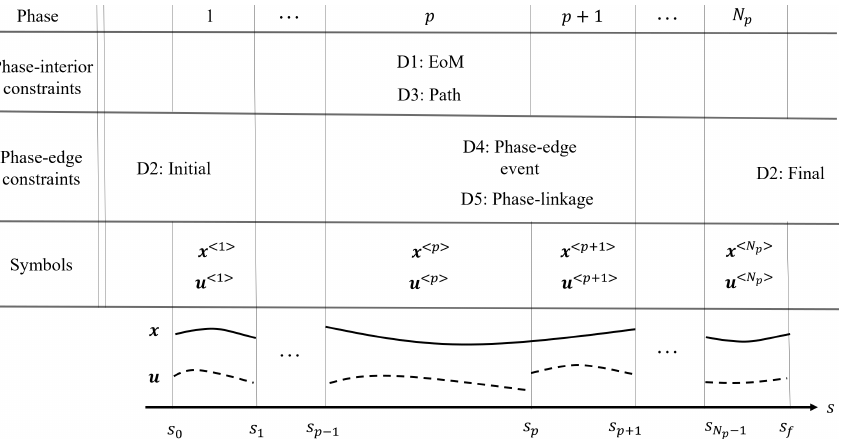
Figure 3. Overview of the constraints and symbols specific to phases. The constraints are categorized as phase-interior constraints and phase-edge constraints. Continuity of the trajectory is assumed for x at phase